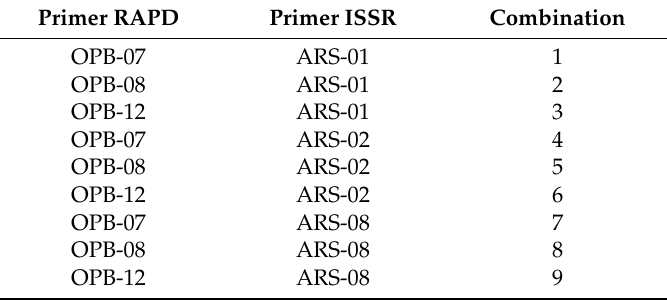
Table 1. Combinations of inter simple sequence repeat (ISSR) and random amplified polymorphic DNA (RAPD) primers for the randomly amplified microsatellite polymorphism (RAMP)